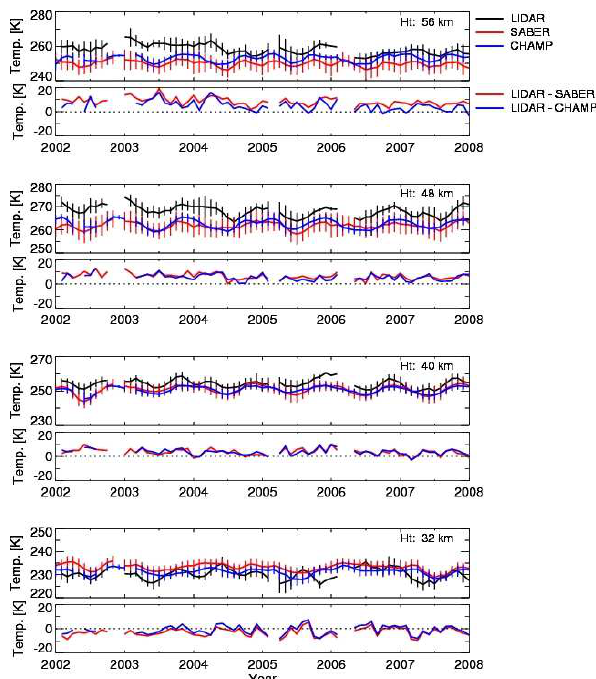
Fig. 9. Temporal evolution of the monthly mean temperature (up- Figure 9: Temporal evolution of the monthly mean temperature (upper plots) and 3 per plots) and differences (lower plots) from LIDAR, SABER and differences (lower plots) from LIDAR, SABER and CHAMP (GPS plus COSMIC) 4 GPS (CHAMP plus COSMIC) observations at four different height regions, 32km, 40km, 48km and observations at four different height regions, 32 km, 40 km, 48 km and 56 km. 5